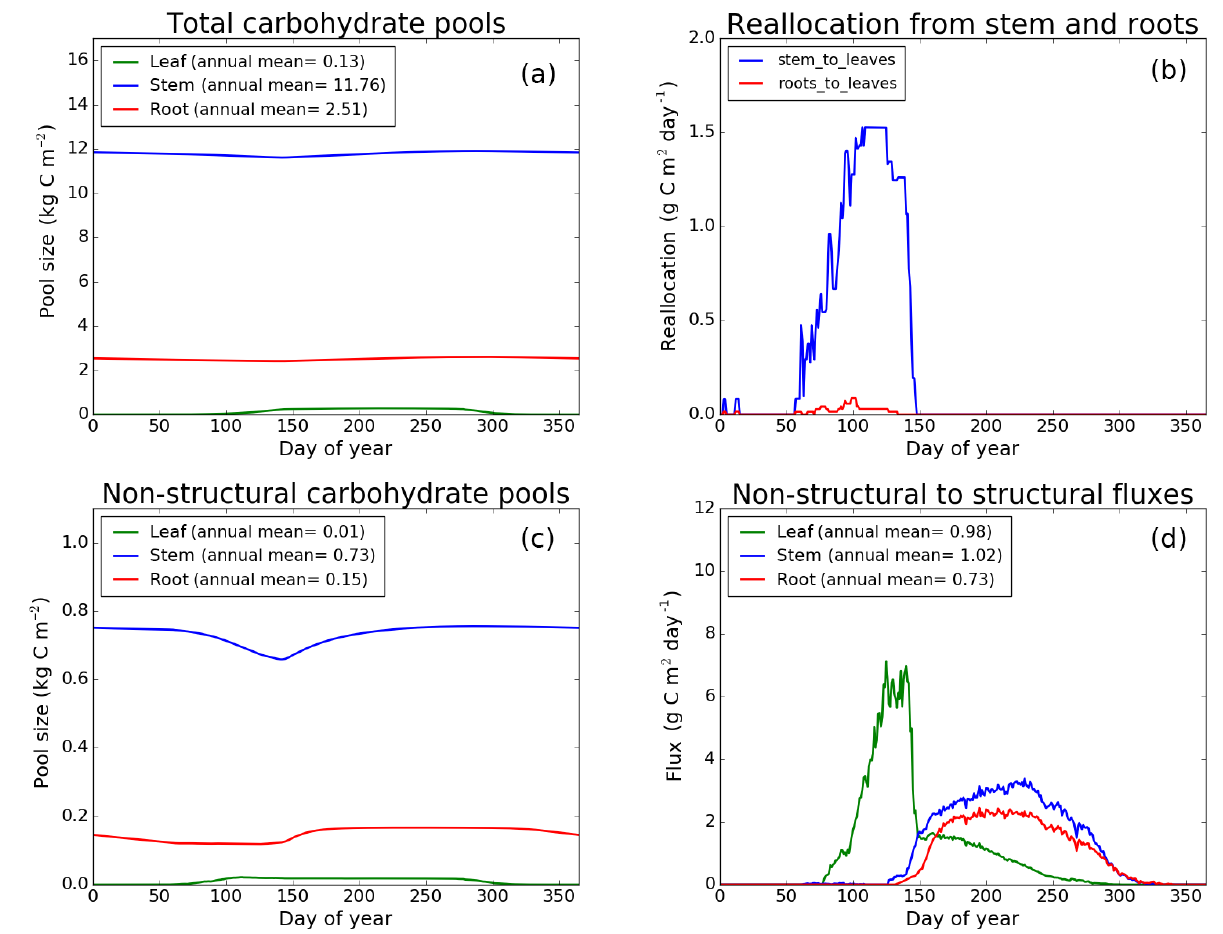
Figure 8. CLASS–CTEM (modified version) simulated values of total (a) and non-structural (c) carbohydrate pools (kgCm − 2 ). Panel (b) shows the reallocation of carbon from non-structural stem and root pools to leaves during leaf onset in spring and panel (d) shows the carbon flux from non-structural to structural pools for leaf, stem, and root components (gCm − 2 day − 1 ) for the US-MMS (Morgan–Monroe State Forest) FLUXNET site. The plots show mean daily values across all years for which the meteorological data were available after the model pools reached